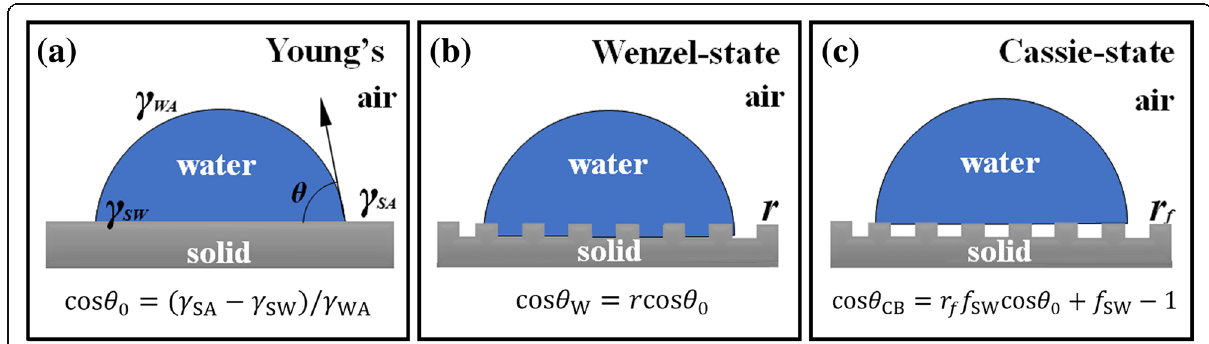
Fig. 1 a Contact condition of the ideal smooth solid surface in the air and the droplets. b Wenzel state [21] when the droplets are in contact with the rough surface. c Cassie-Baxter state [22] when the droplets are in contact with the rough